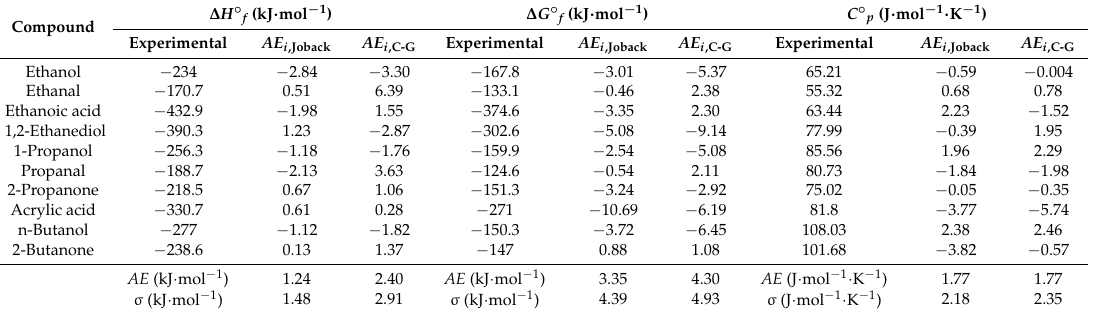
Table A4. Comparison of group contribution method estimations with experimental values of thermodynamic properties for compounds with similar structures and functional groups